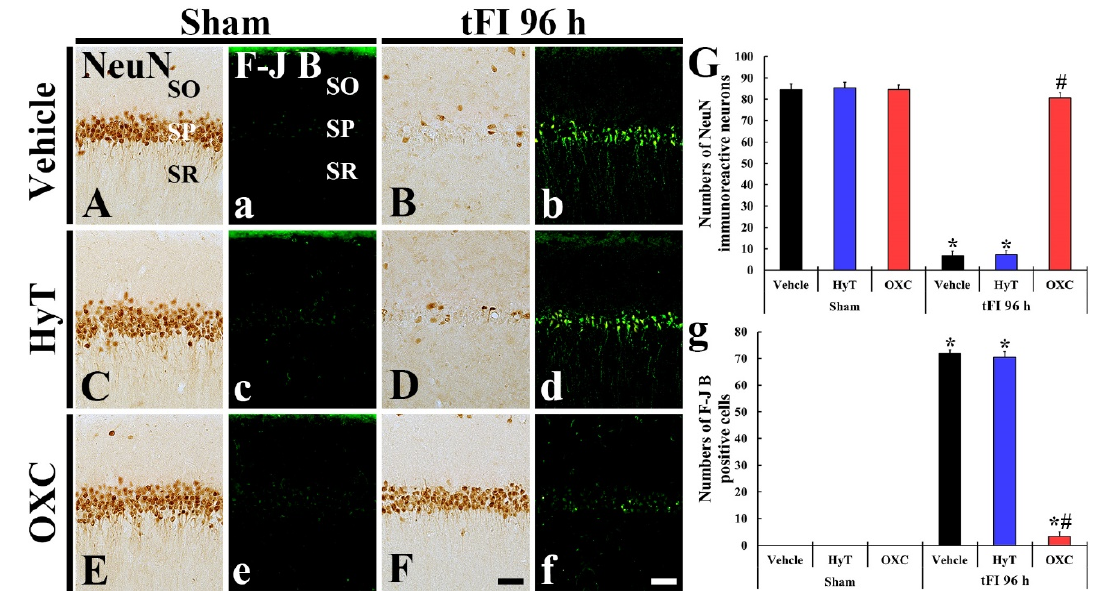
Figure 8. ( A – F and a – f ) NeuN immunohistochemistry ( A – F ) and F-J B staining ( a – f ) in the CA1 region of the sham+vehicle ( A , a ), sham+HyT ( C , c ), sham+OXC ( E , e ), tFI+vehicle ( B , b ), tFI+HyT ( D , d ), and tFI+OXC ( F , f ) groups on Day 4 after tFI or sham operation. Few NeuN + and many F-J B + cells were observed in the SP of the tFI+vehicle and tFI+HyT groups. However, in the tFI+OXC group, many NeuN + and few F-J B + cells were found in the SP on Day 4 after tFI. ( G , g ) Mean numbers of NeuN + ( G ) and F-J B + ( g ) cells. The bars indicate the means ± SEM ( n = 7 for each group; * p < 0.05 vs. sham+vehicle group, # p < 0.05 vs. corresponding time of the tFI+vehicle group). SO, stratum oriens; SR, stratum radiatum. Scale bars = 100 μ m.